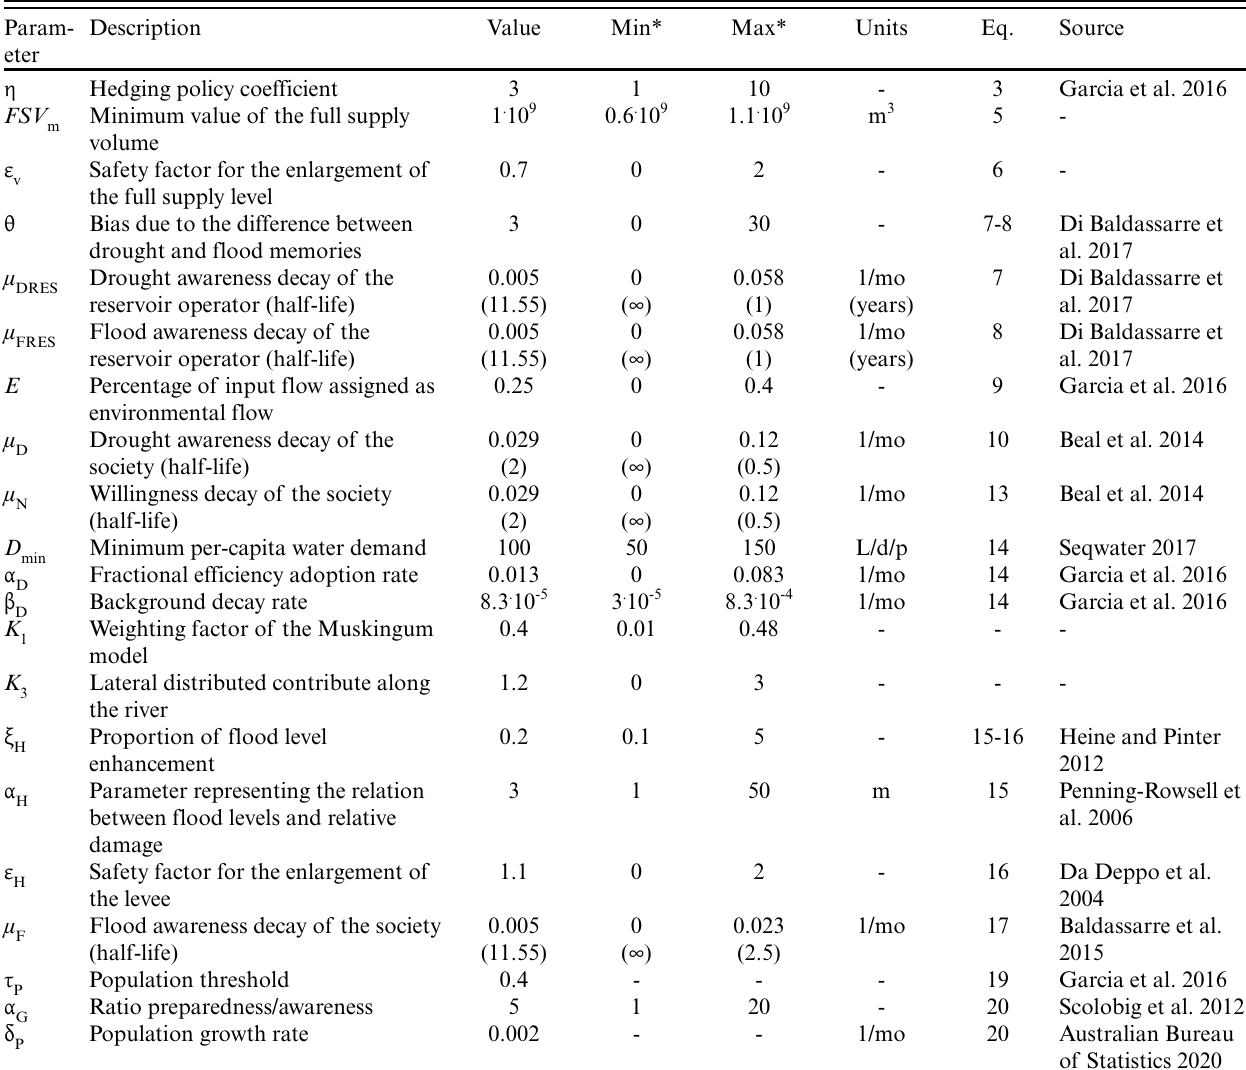
Table 4 . Summary of the model parameters. Note: FSV = full supply volume. Param­ eter